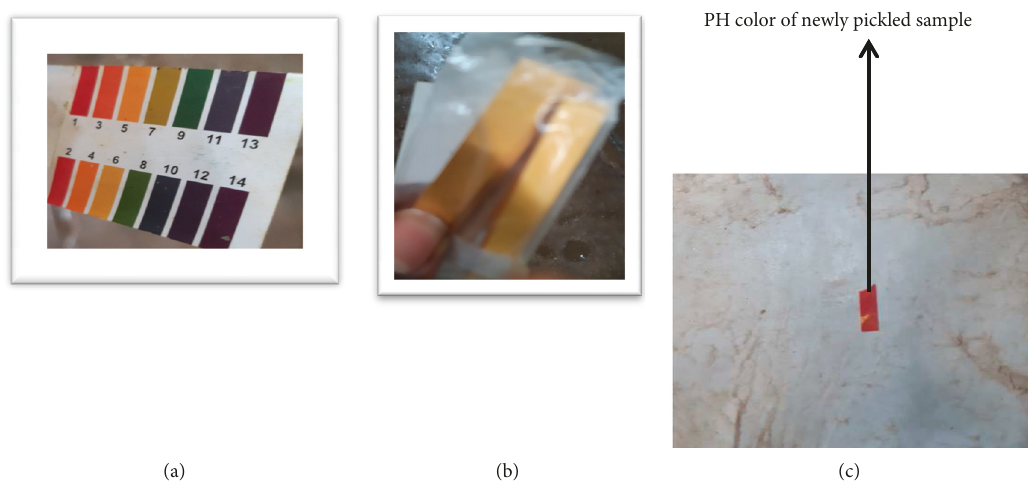
Figure 3: (a) Universal color indicator; (b) pH litmus paper; (c) pH value/color of newly pickled sheep